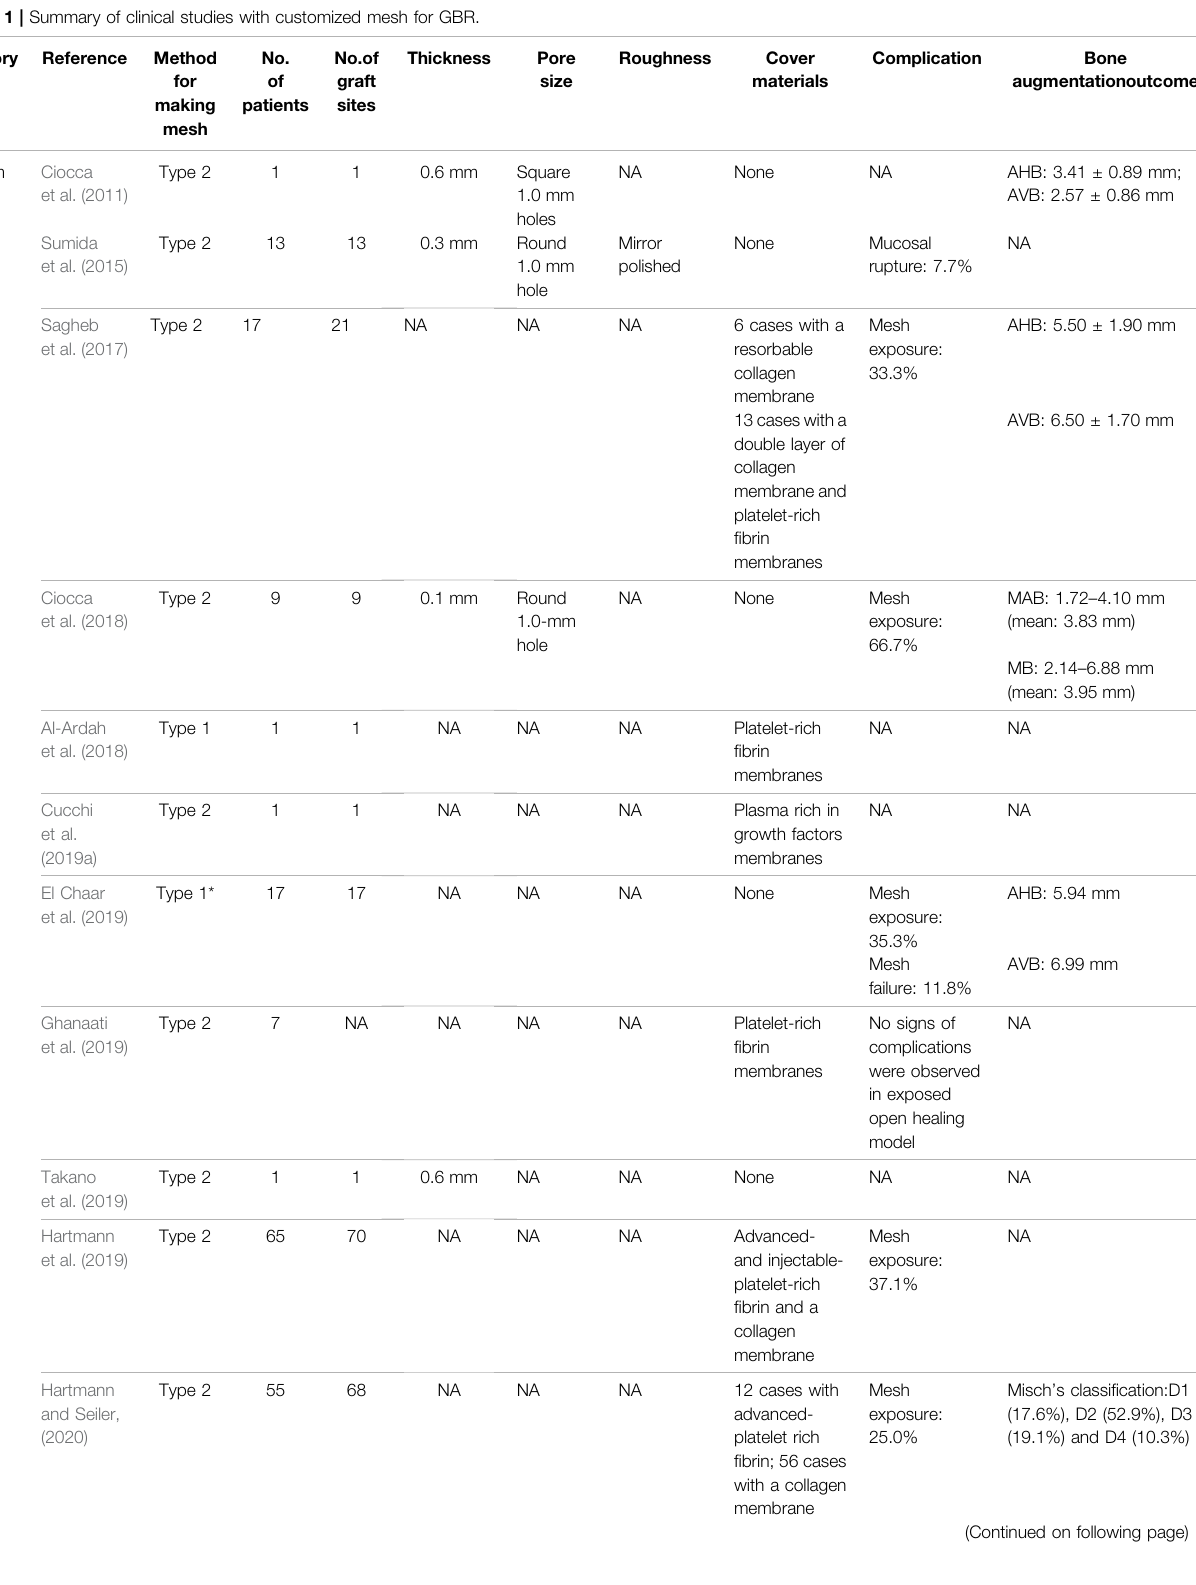
TABLE 1 | Summary of clinical studies with customized mesh for GBR. Category